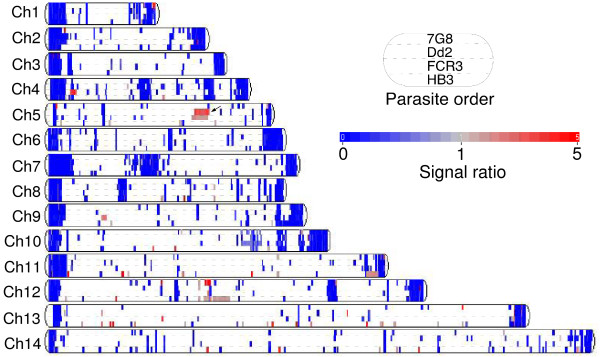
Copy number/segmentation analyses showing amplified and highly variable or deleted regions on 14 chromosomes. Amplified/deleted regions were displayed as a signal heat map (red, amplified; blue, deleted or highly polymorphic) from each parasite. The 14 chromosome diagrams showed amplified (red, > 1.5) or deleted/highly variable regions (blue, < 0.67) after filtering for regions 0.3 kb or larger. The dashed lines separate the four parasites in each chromosome in the order of 7G8, Dd2, FCR3, and HB3. The arrow indicates the chromosome 5 regions amplified in Dd2 and FCR3.